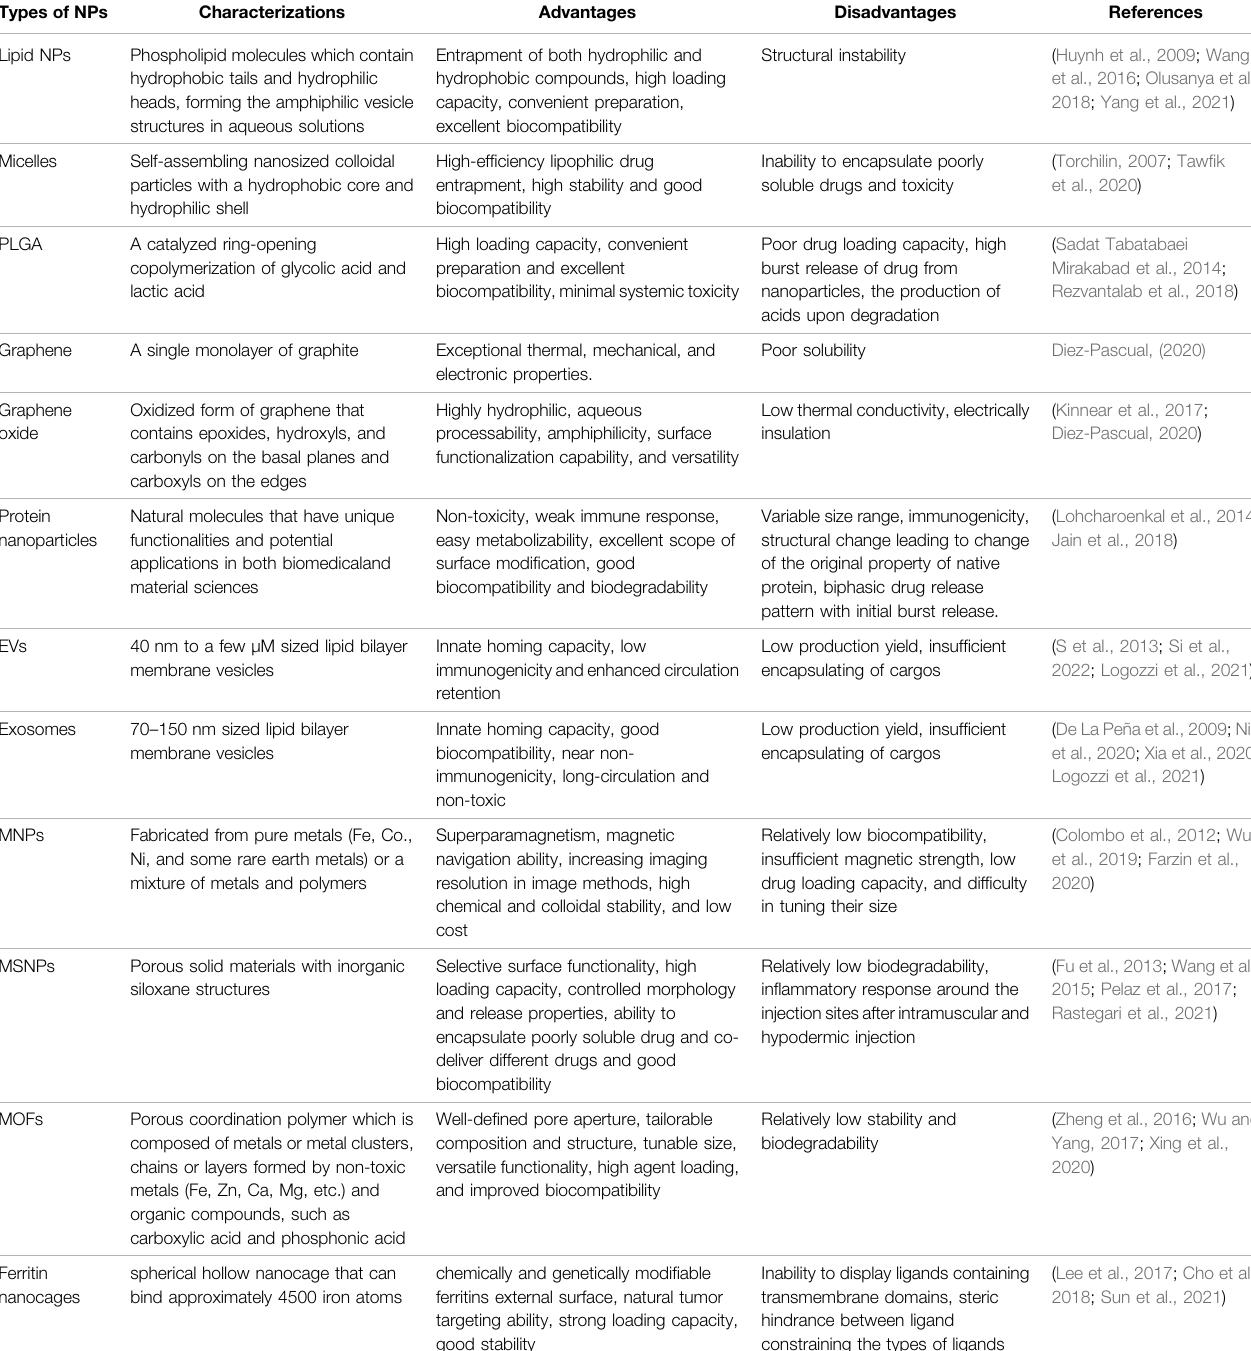
TABLE 2 | Detailed information about the charaterizations, advantages and disadvantages of each type of